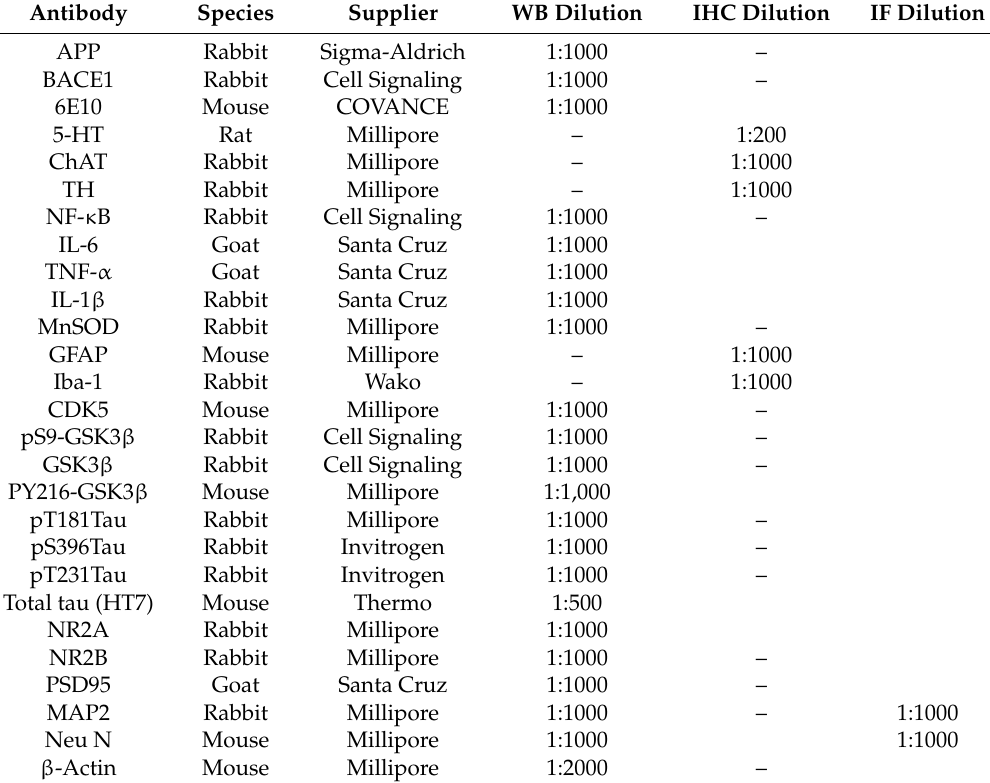
Table 1. List of primary